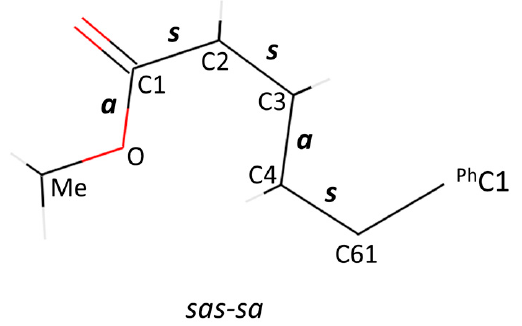
Figure 1. A diagram of the ester part for ( sas-sa )[60]PCBM illustrating the nomenclature for the conformers used in this communication. It should be understood that C61 also attaches to carbons C1 and C9 of the fullerene (which is omitted for clarity).